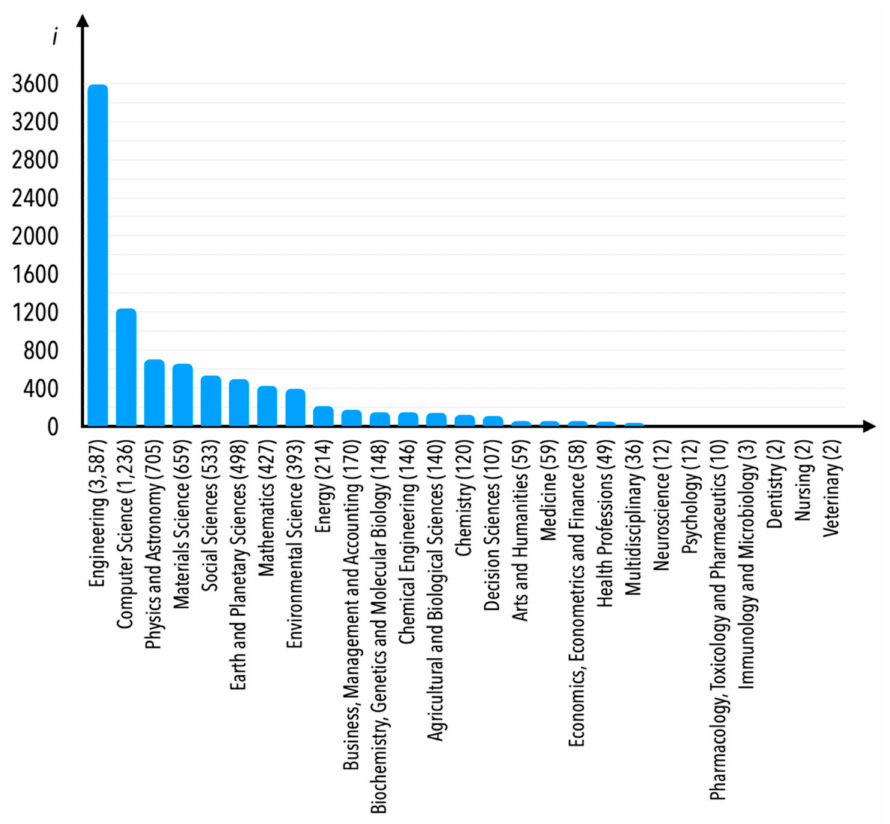
Figure 5. Number of publications ( i ) in the research area of railway transport condition monitoring per particular subject